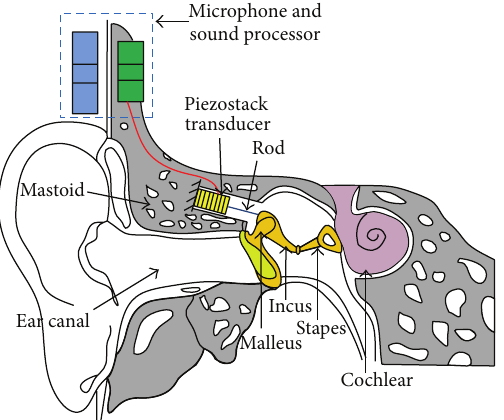
Figure 1: Schematic of the proposed middle ear implant.